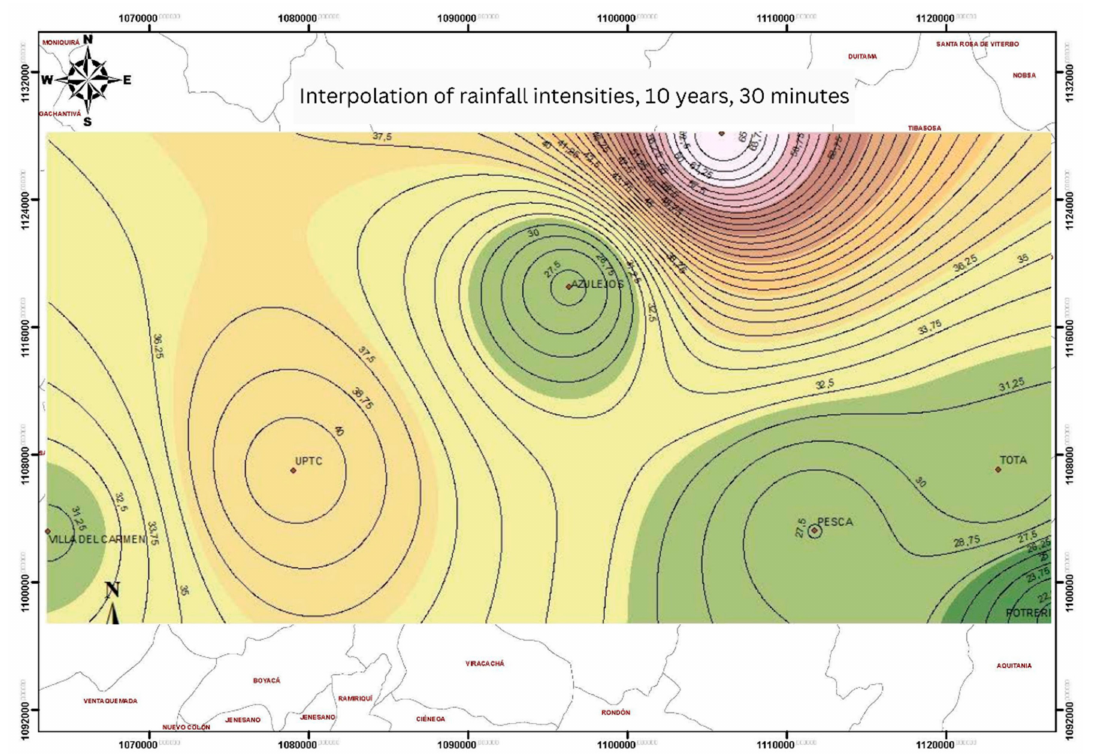
Figure 2. Isoline map of mean intensity of